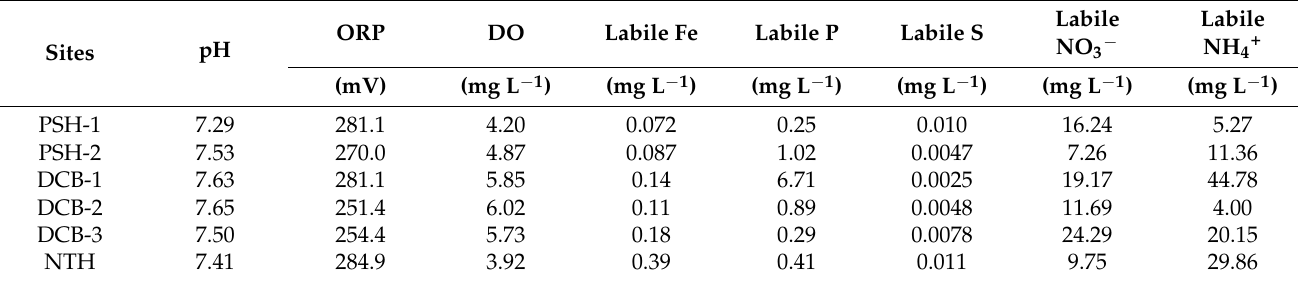
Table 1. Physicochemical properties of overlying